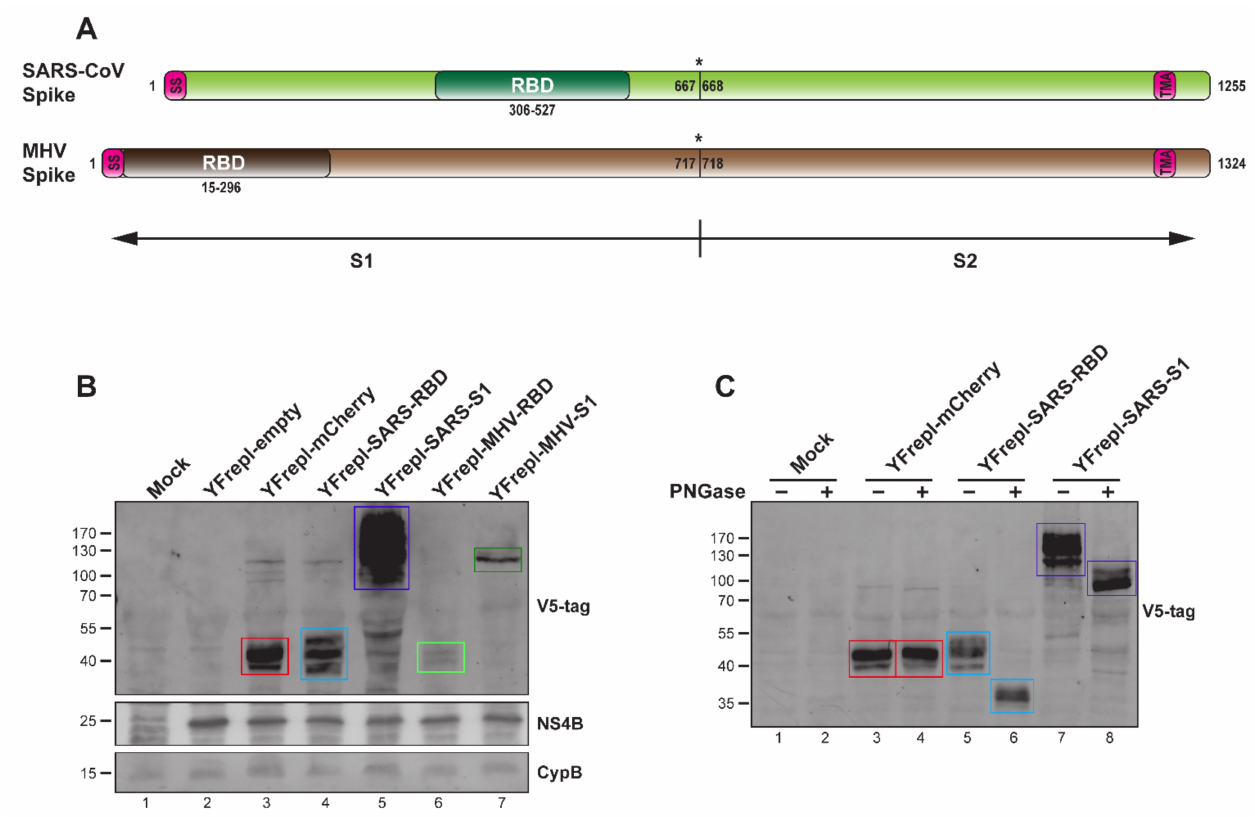
Figure 4. Characterization of YF-replicons expressing various coronavirus inserts. ( A ) Schematic representation of the SARS-CoV and MHV S proteins. SS—signal sequence; TMA—transmembrane anchor. Cleavage site between S1 and S2 is illustrated with an asterisk. ( B ) Western blot analysis of the expression of the RBD or S1 domains of SARS-CoV and MHV, as well as mCherry, in lysates from cells containing the respective replicons. The quantities of the cell lysates loaded on gel were normalized for the percentage of replicon-positive cells, as determined by flow cytometry. ( C ) Western blot analysis of the glycosylation status of the RBD and S1 domains of SARS-CoV or mCherry after PNGase treatment of lysates from cells containing the respective YF-replicons. ( B , C ) Bands with the expected size for all inserts are indicated with colored rectangles: red for mCherry, light blue for MERS-CoV RBD, purple for MERS-CoV S1, light green for MHV RBD, and dark green for MHV S1. The antibodies used are shown on the right. A protein size marker is shown on the left. CypB and YFV NS4B were used as internal and replicon expression controls,